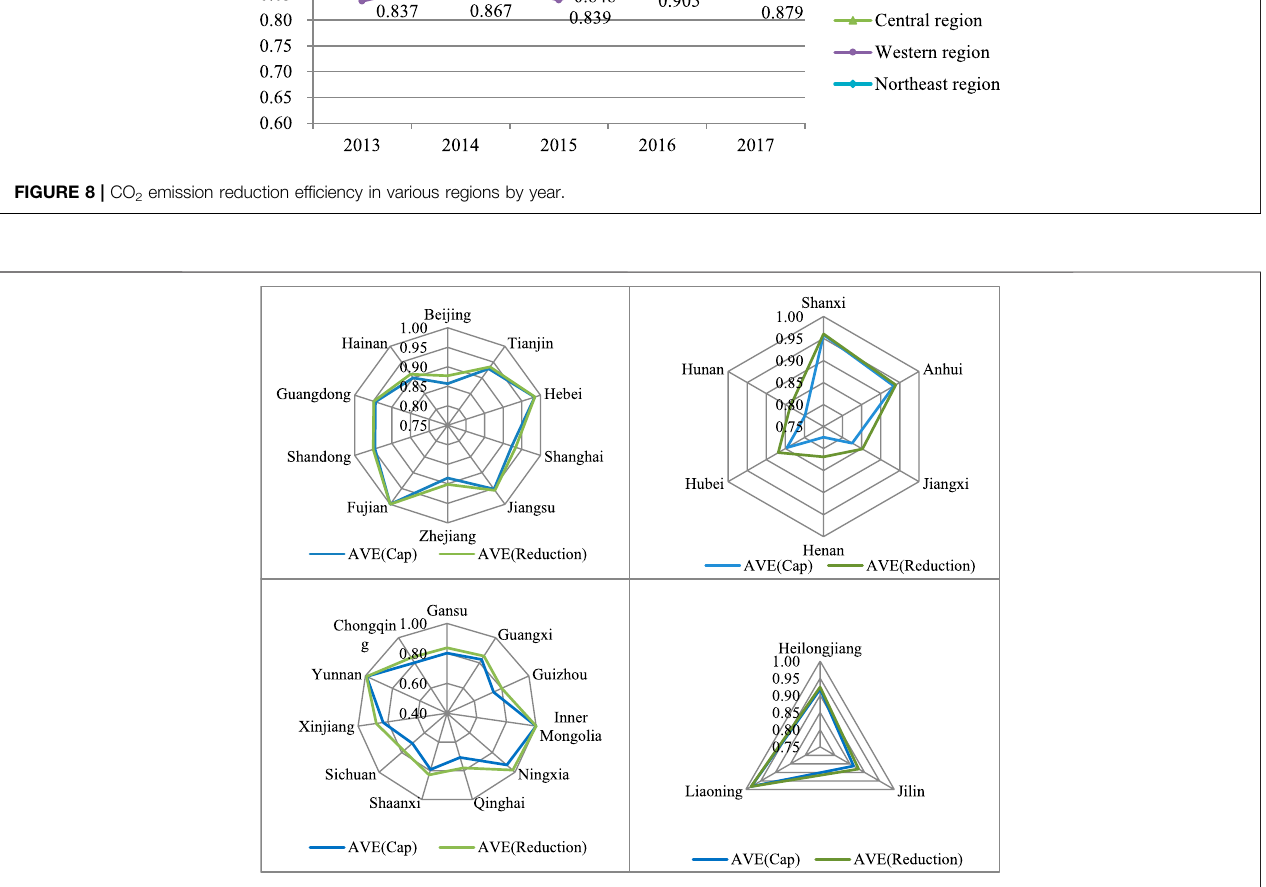
FIGURE 9 | Average annual installed capacity ef fi ciency and average annual carbon emission reduction ef fi ciency in various regions.